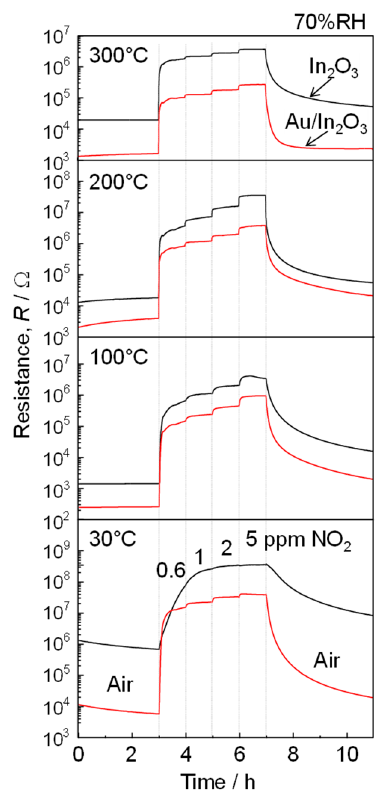
Figure 3. Response transients of the In 2 O 3 and Au / In 2 O 3 sensors to NO 2 (0.6, 1, 2, 5 ppm) in wet air (70%RH at 25 °C) at 30, 100, 200, and 300 °C.